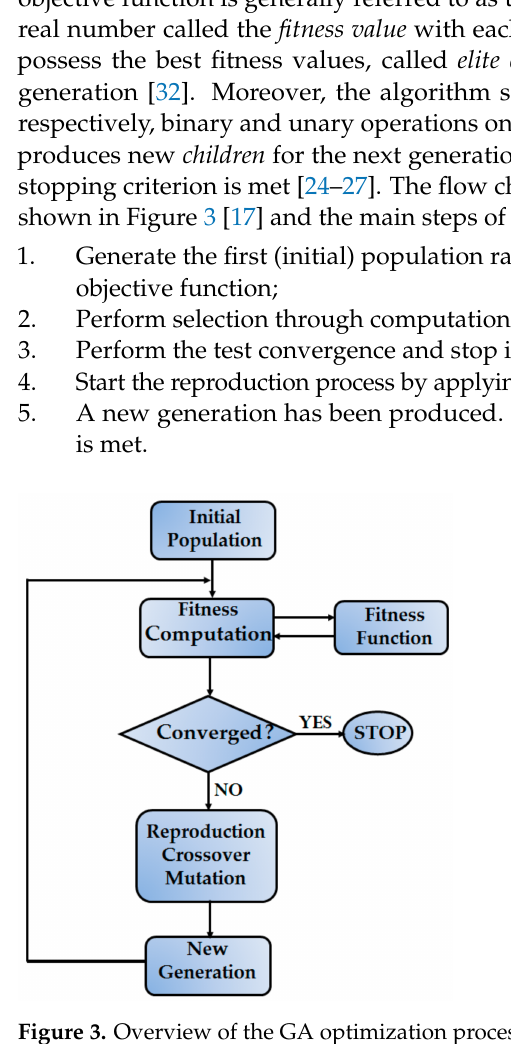
Figure 3. Overview of the GA optimization